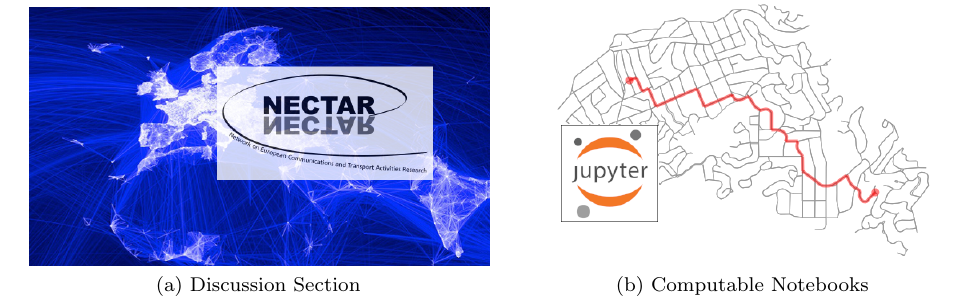
Figure 1: New publication types in